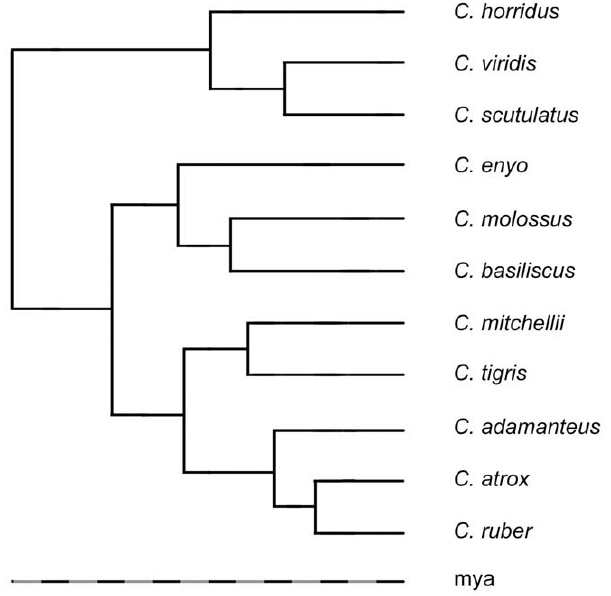
Figure 1. Composite phylogeny of 11 rattlesnakes in the genus Crotalus . Phylogenetic relationship of 11 rattlesnake species based on a composite phylogeny from a mixed model Bayesian analysis and maximum parsimony. The color offsets on the bar labeled millions of years ago (mya) are in million year increments.